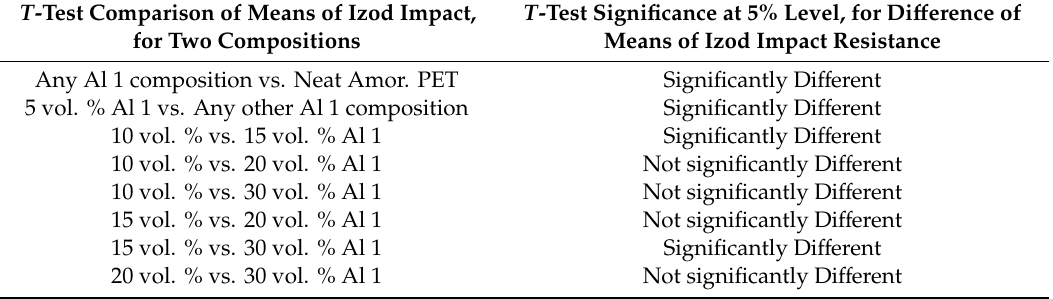
Table 8. For the unpaired t -test, the null hypothesis was there is no di ff erence between the means of the two compositions that are compared, and the alternative hypothesis applied was the two means are di ff erent at the 5% significance level. ‘Significant’ means the alternative hypothesis is accepted and there is a di ff erence between the means, and ‘non-significant’ means we accept the null hypothesis that there is no di ff erence in the means. vs. is